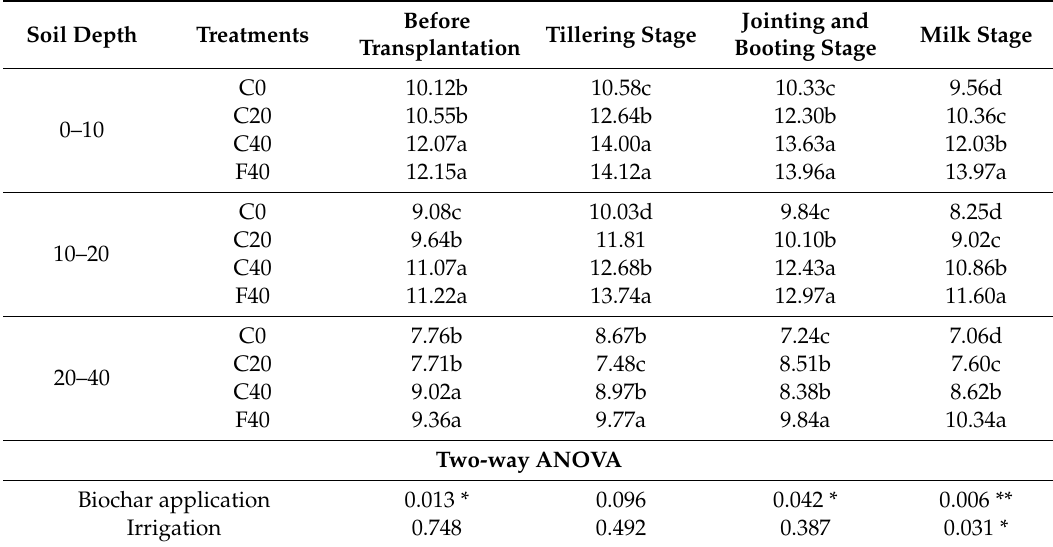
Table 1. Characteristics of total soil organic carbon (SOC) under di ff erent water-carbon regulation scenarios in paddy fields (g /